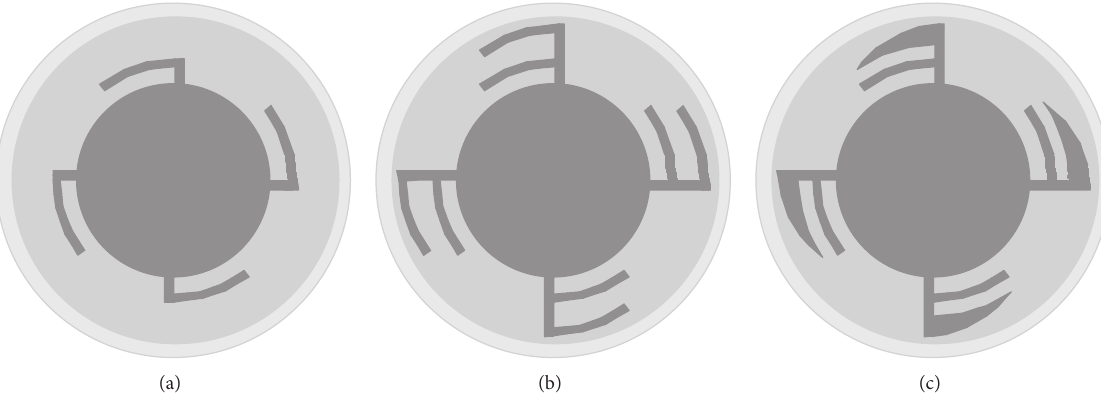
Figure 2: Three prototypes of the antenna. (a) Ant. I, (b) Ant. II, and (c) Ant. III.